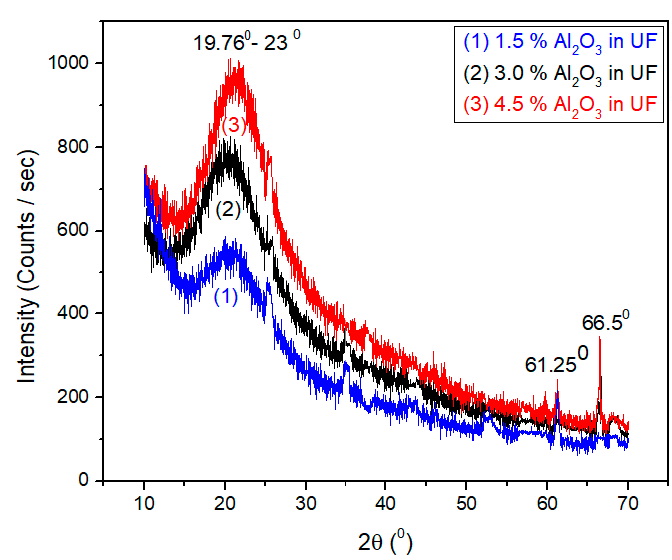
Figure 8. X-ray diffraction of different concentration of alumina nano-particles in urea-formaldehyde resin.